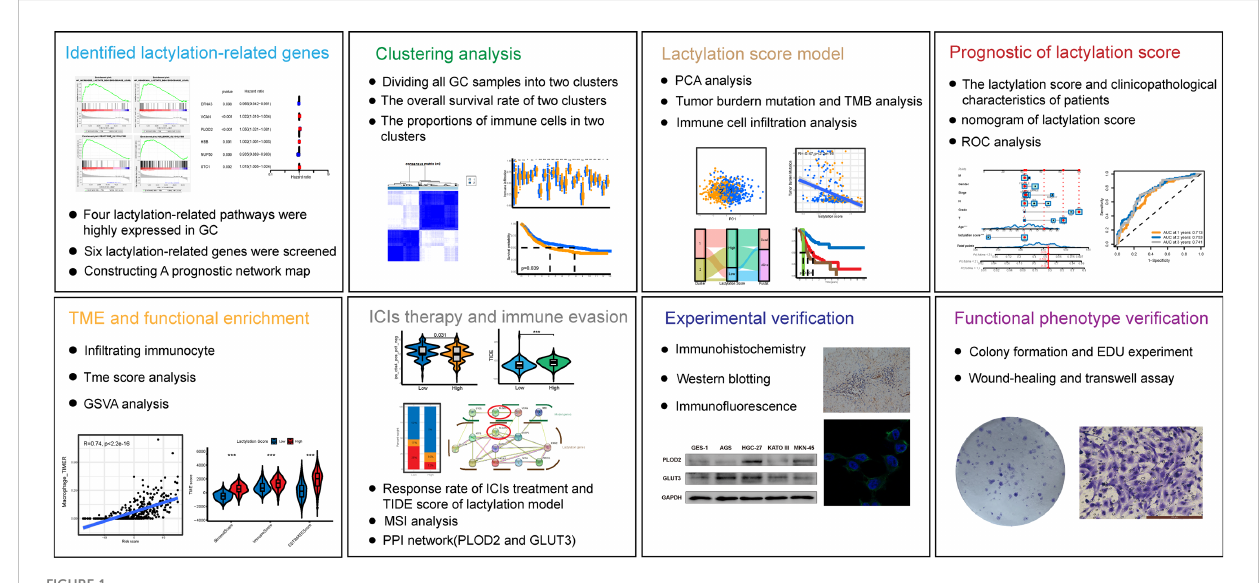
FIGURE 1 Flowchart of the